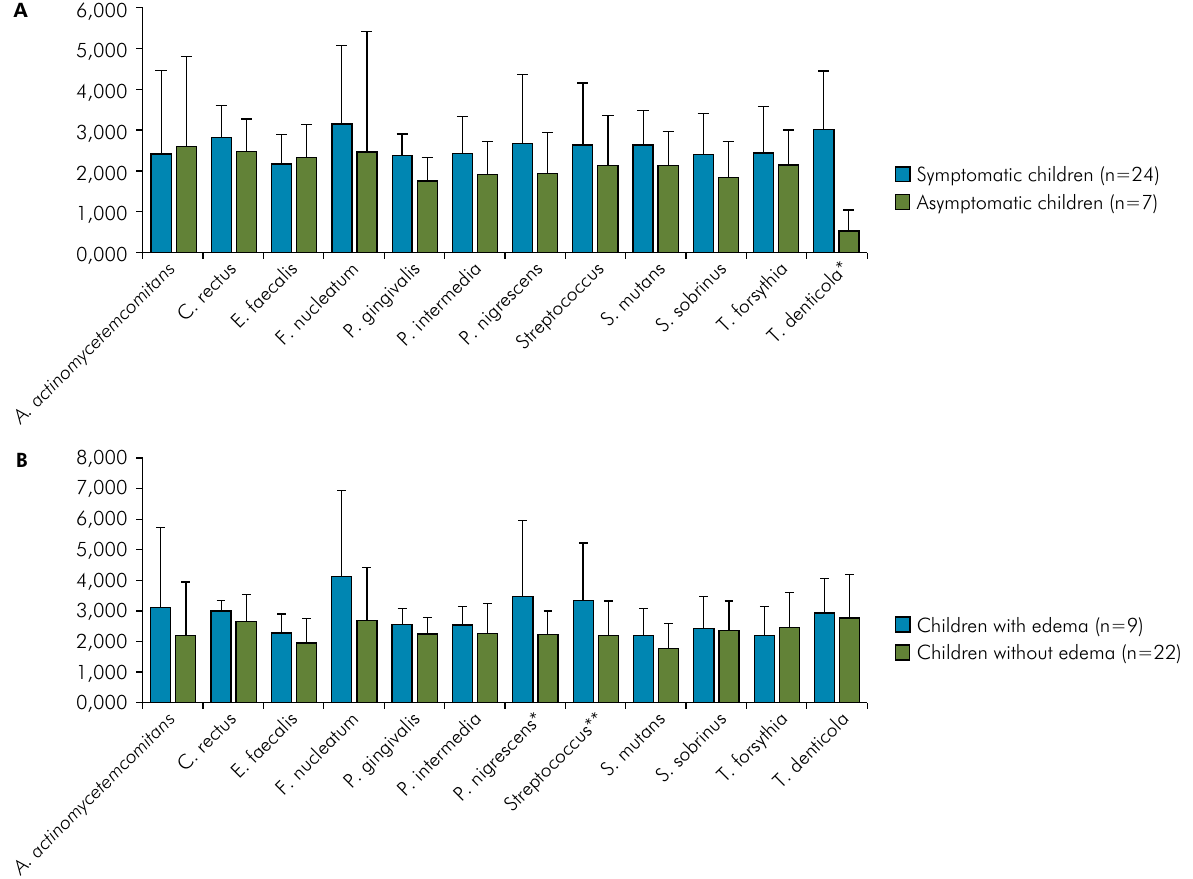
Figure 2. A.Density of bacteria (cells 10 8 mL -1 ) in children with and without pain symptoms. Bars = standard deviation, and asterisks = significant difference.B. Density of bacteria (cells 10 8 mL -1 ) in children with and without edema. Bars = standard deviation, and asterisks = significant